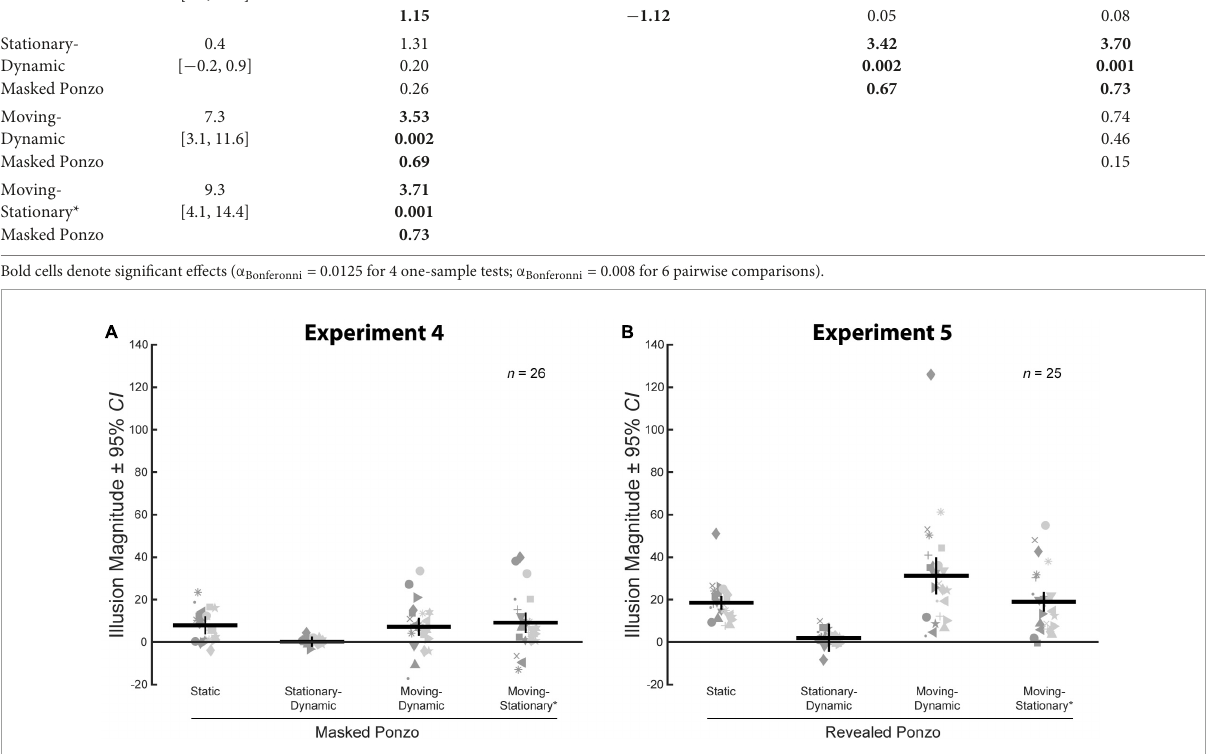
FIGURE9 (A) Illusion magnitudes for the four conditions with a surrounding context in Experiment 4. Statistical comparisons against zero and across conditions are summarized in Table 4 . (B) Illusion magnitudes for the four conditions with a surrounding context in Experiment 5. Statistical comparisons against zero and across conditions are summarized in Table 5 . Conventions are the same as in Figure 3